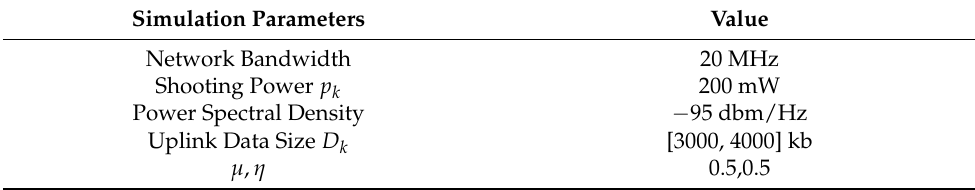
Table 1. Simulation parameter